Question: Sum up the contents of this chart in one sentence.
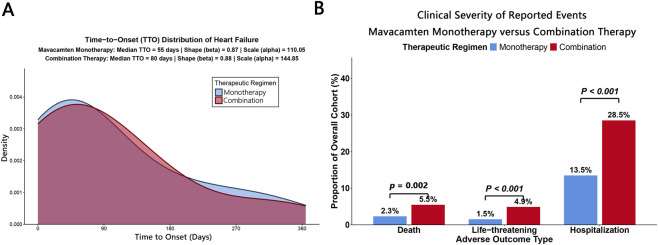
Answer: Temporal dynamics and reported clinical severity of heart failure-related reports. (A) TTO distribution fitted with a Weibull hazard model. Both the mavacamten monotherapy (β = 0.87) and combination therapy (β = 0.88) groups exhibited an “early failure” hazard profile (β < 1). (B) Comparison of severe reported outcomes between reports involving mavacamten monotherapy and reports involving concomitant CYP inhibitor exposure. Abbreviations: TTO, time-to-onset; CYP, cytochrome P450; β, Weibull shape parameter.